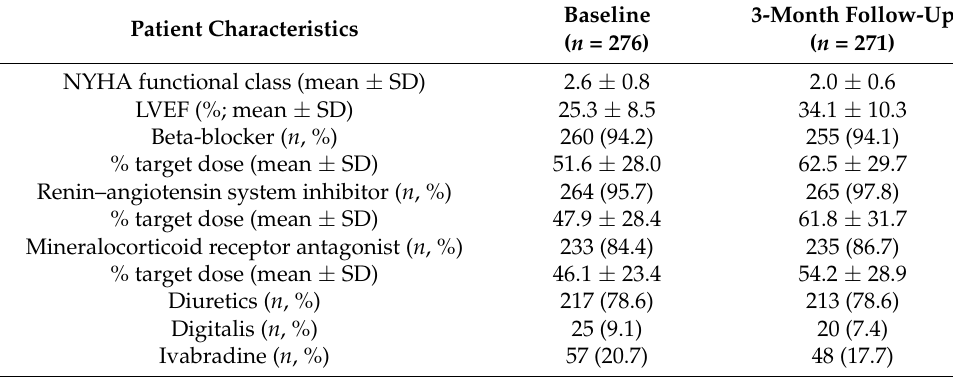
Table 1. Patient characteristics at WCD prescription and 3-month follow-up; SD = standard deviation; LVEF = left ventricular ejection fraction; WCD = wearable cardioverter–defibrillator.